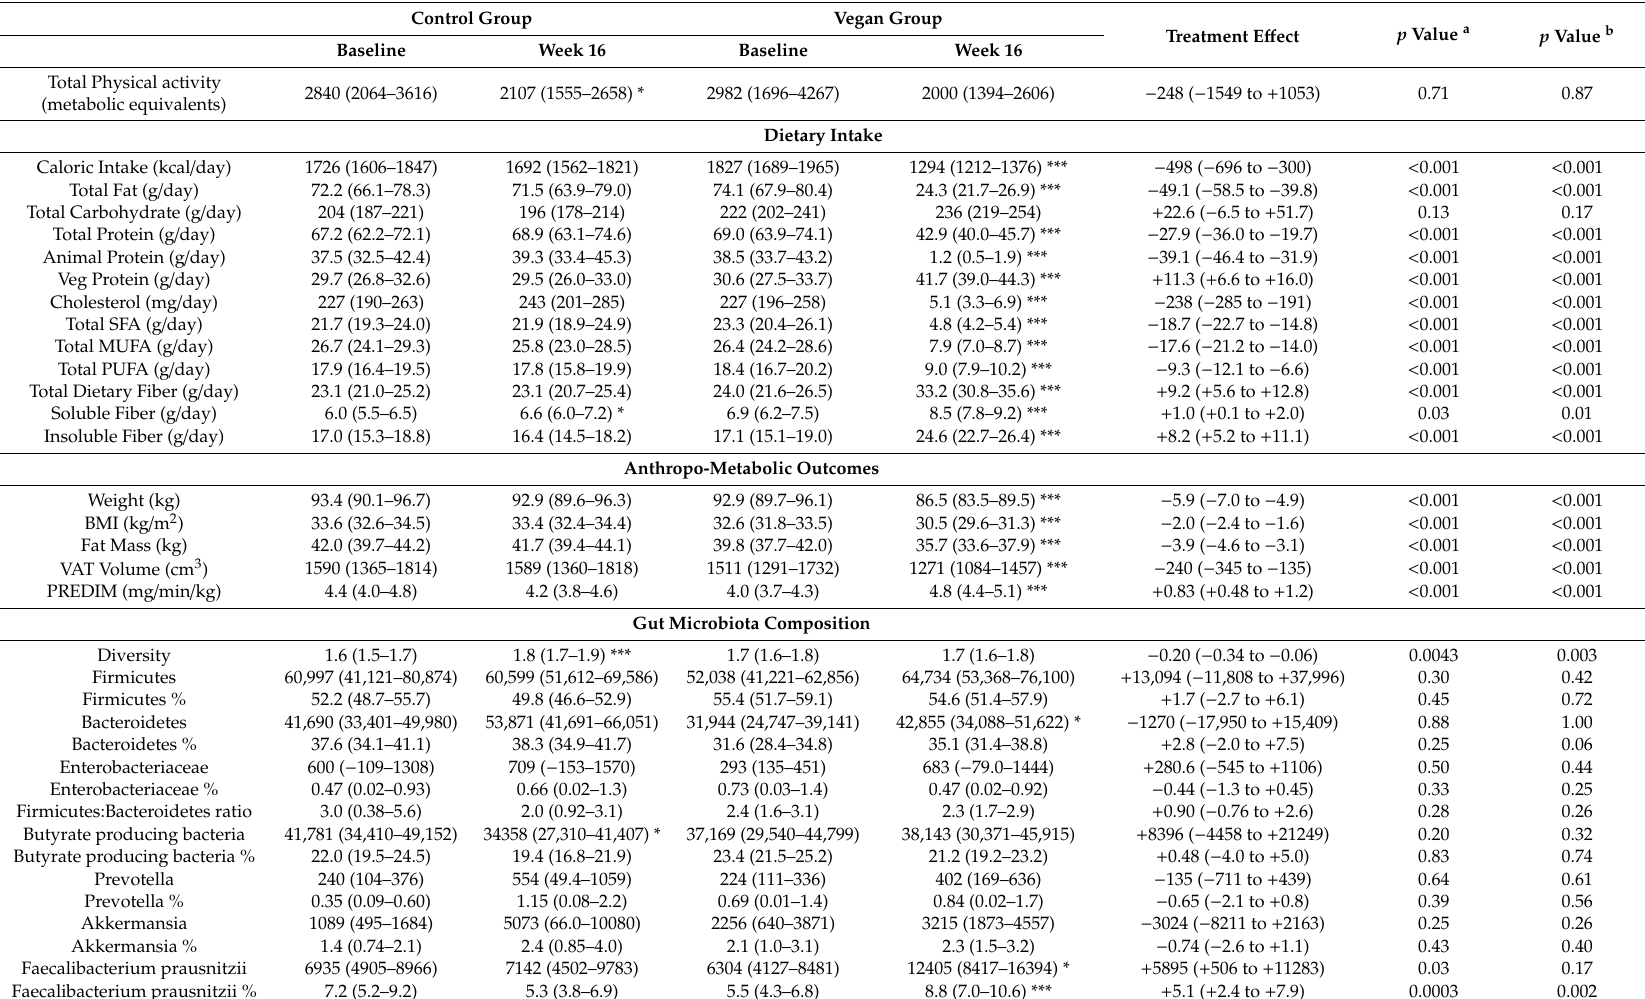
Table 2. Changes in dietary intake, anthropo-metabolic outcomes, and gut microbiome during the